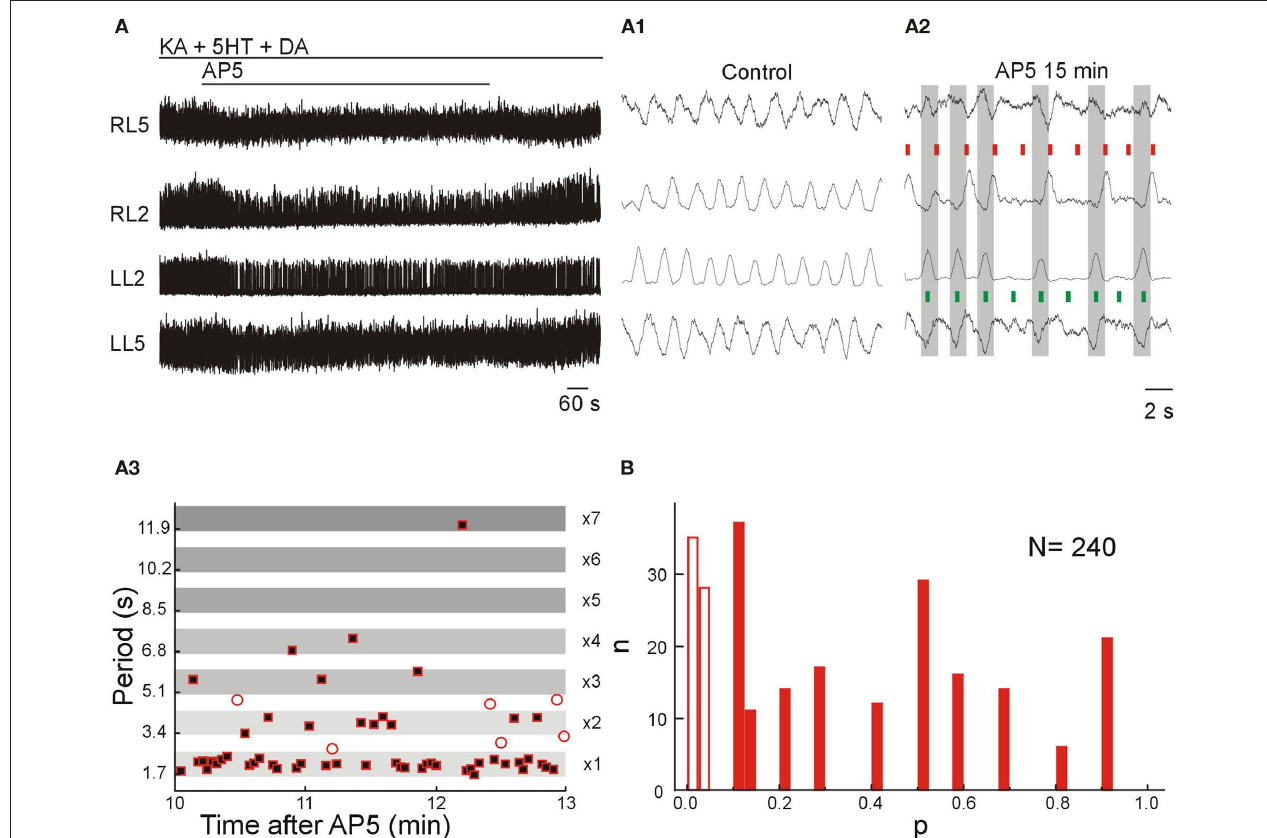
Figure 6 | NMDArs have a small effect on frequency control but contribute to the transmission of locomotor signal to motor neurons. (A) Application of AP5 (30 μM) during locomotor-like activity elicited by KA-5HT-DA led to non-resetting flexor deletions with an unchanged frequency of the rhythm and preserved left–right and flexor–extensor coordination on the spared bursts. VR activity was recorded in AC mode for RL2/RL5 and in DC mode for LL2/LL5. (A1,A2) Expansion of VR recordings from (A) in control conditions (A1) and after 15 min of AP5 application (A2) . Note that despite the occurrence of bilateral flexor deletions, the frequency of the rhythm [red bars right flexors (RL2); green bars left flexors (LL2)], the left–right alternation (large gray bars) and the flexor–extensor alternation (red